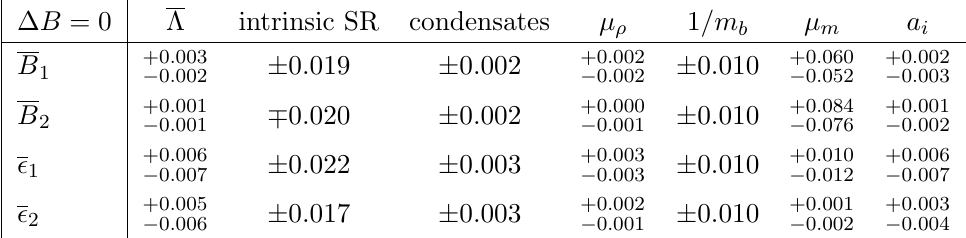
Table 3 . Individual errors for the Bag parameters of the (cid:1) B = 0 matrix elements.